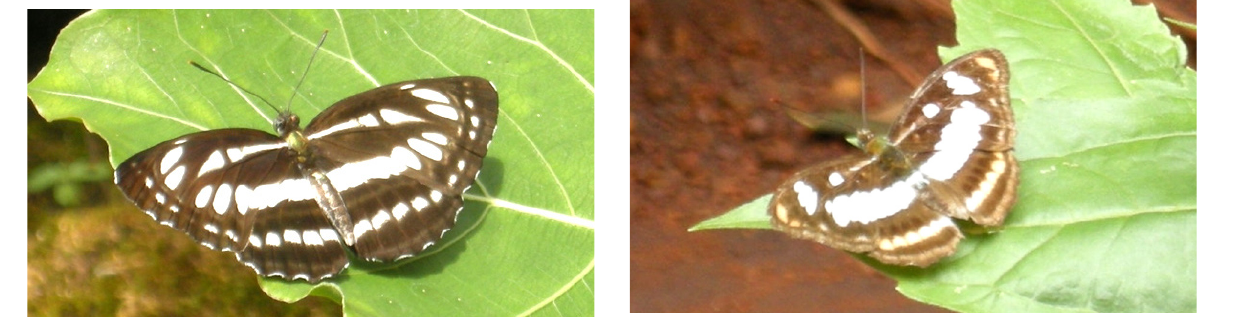
Image 7. Colour Sergeant Athyma nefte Image 4. Common Sailer Neptis hylas